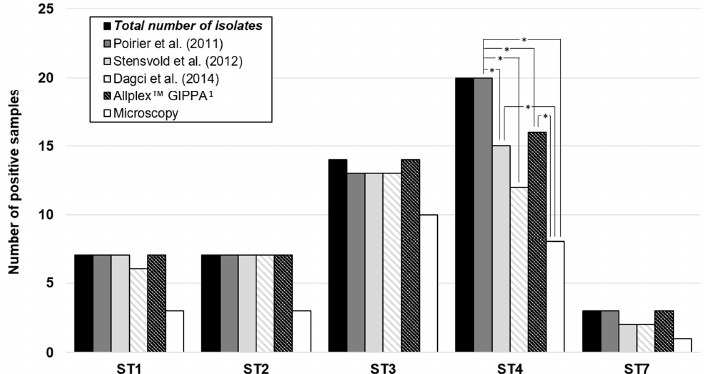
Figure 2. Detection of Blastocystis according to subtypes and diagnosis methods. The total number of positive isolates for each subtype, all methods included, is represented in dark. Each different method is also represented. *: p < 0.05. 1 Gastrointestinal Panel-Parasite Assay.